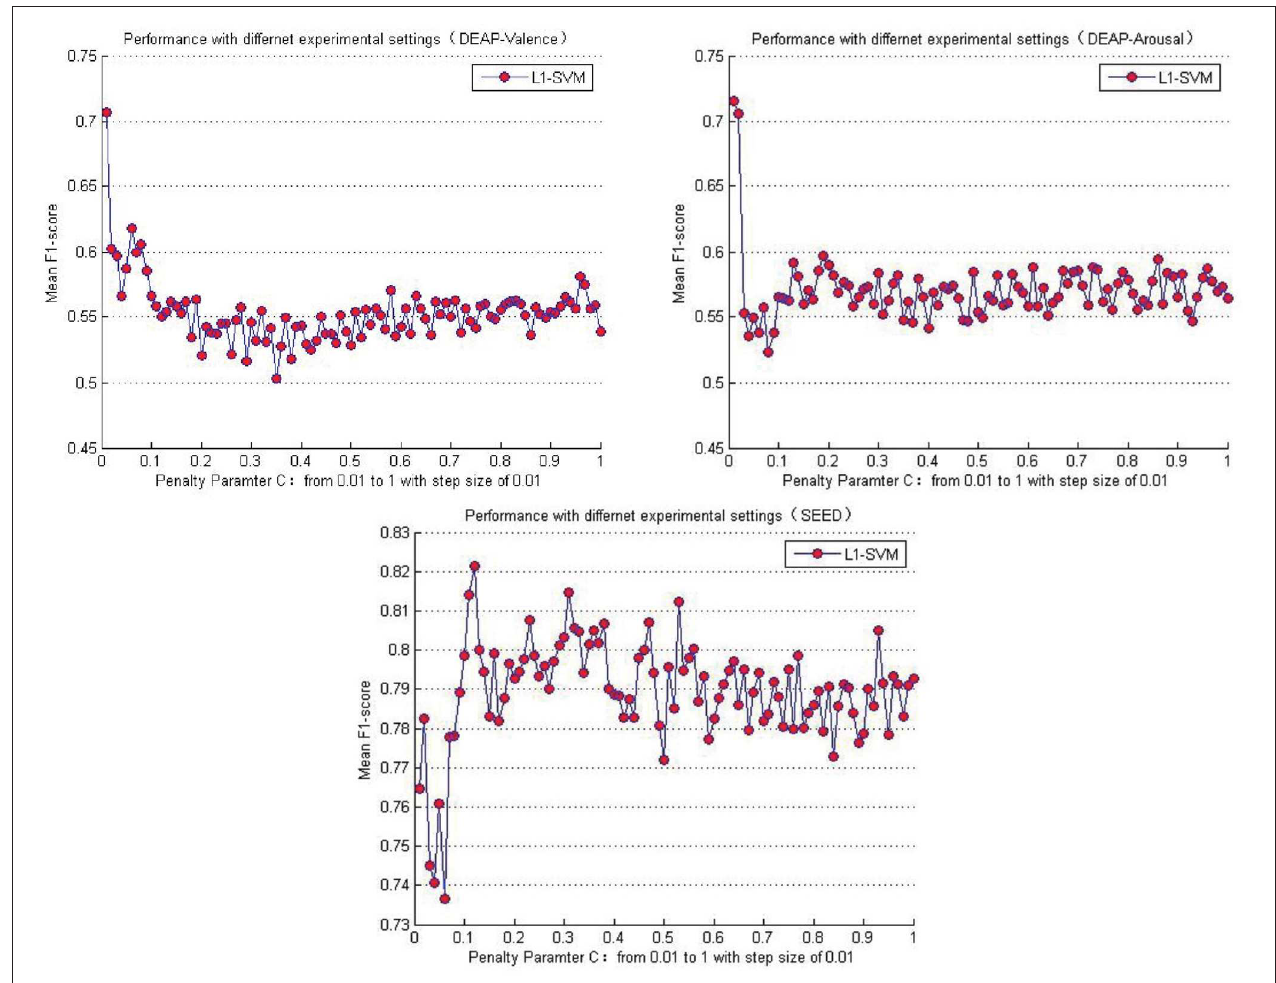
FIGURE 6 | Mean cross-subject recognition performance with different settings when L1-SVM based approach is applied.